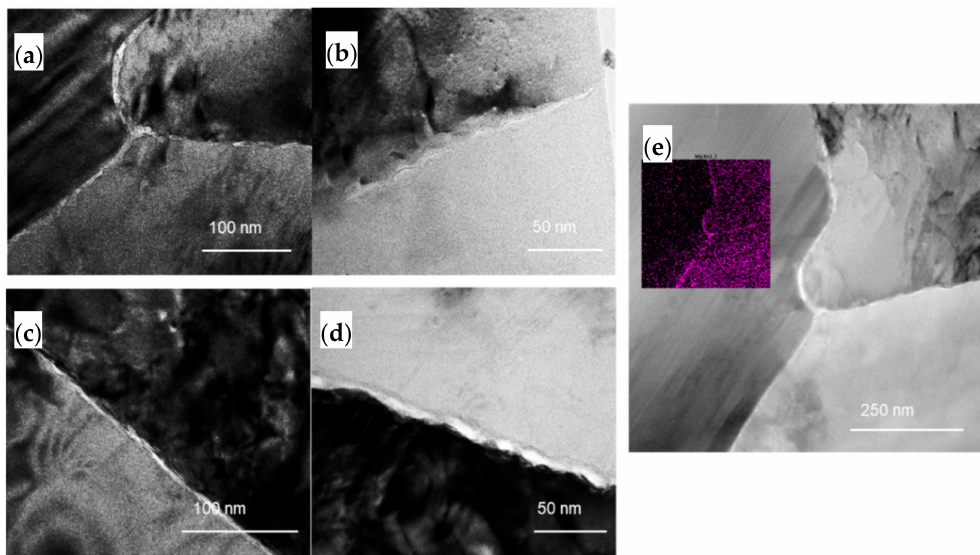
Figure 13. TEM of β precipitates in: ( a ) CR20 alloy, 48 h; ( b ) CR50 alloy, 48 h; ( c ) CR20 alloy, 207 h; ( d ) CR50 alloy, 207 h; and ( e ) TEM-EDS (Mg element) CR20 alloy, 48